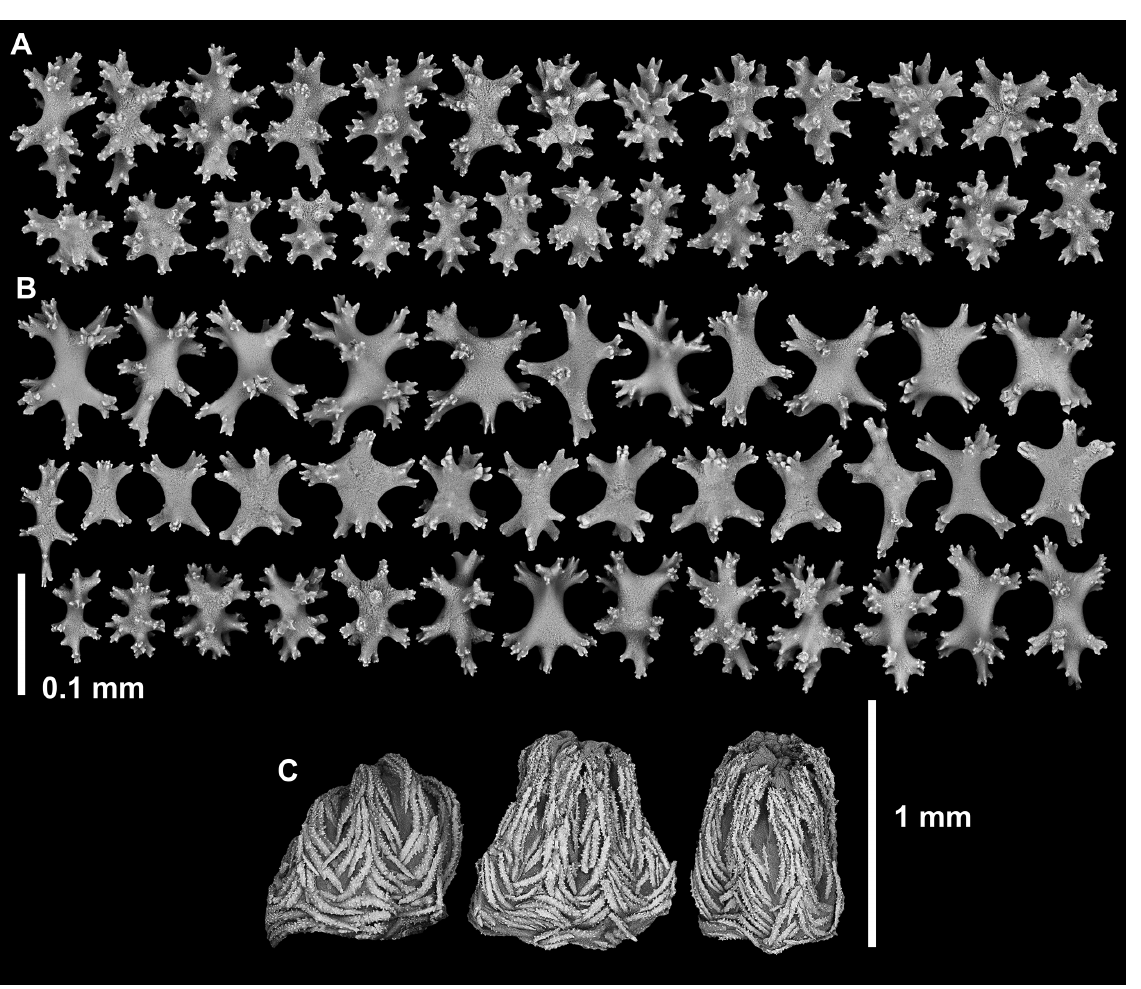
Fig. 13. Kotatea kapotaiora gen. et sp. nov., holotype (NIWA 3974), SEMs of sclerites. A . Base surface. B . Base interior. C . Polyps (in